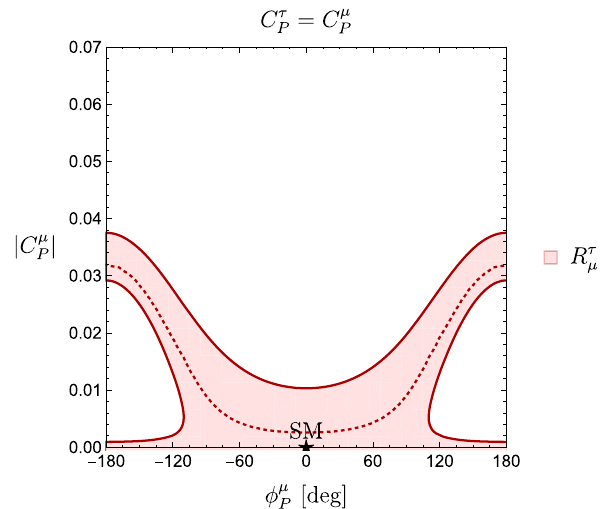
μ μ | plane, assuming flavour – | C P P